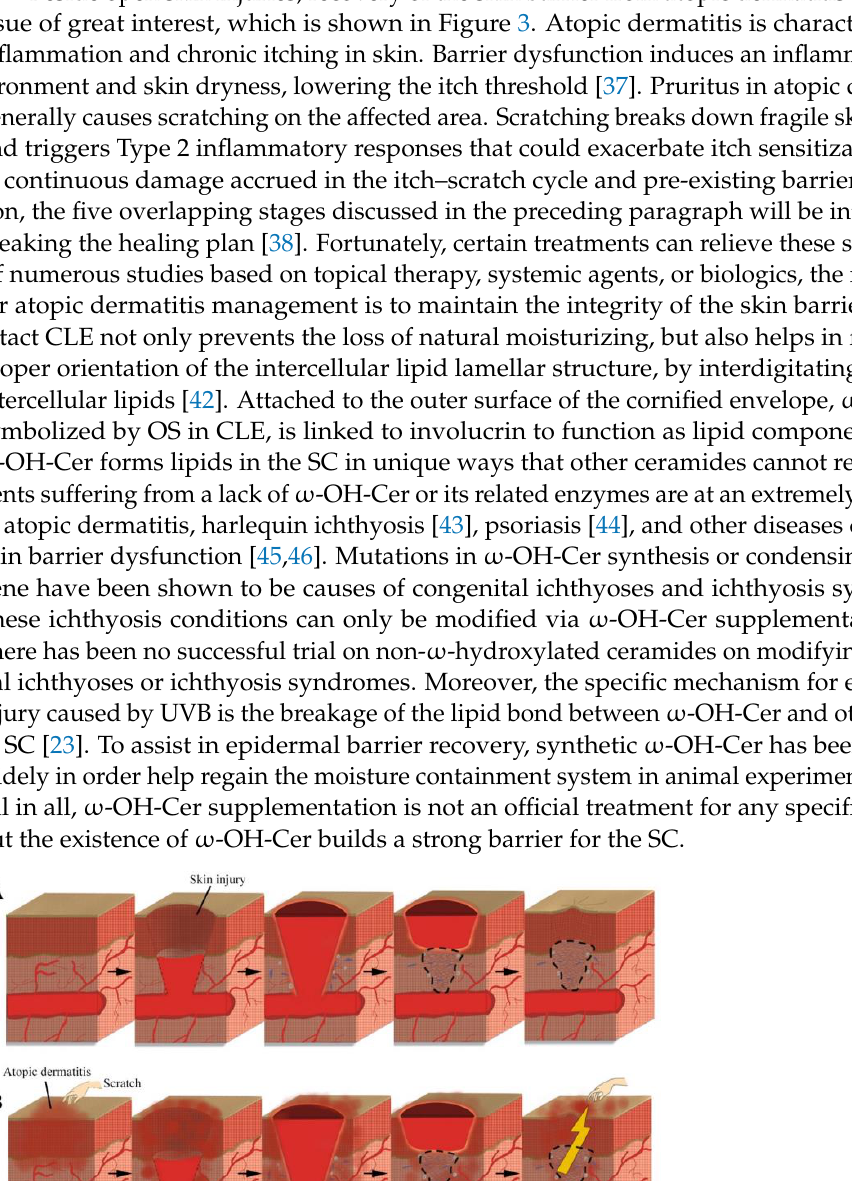
Figure 3. Schematic diagram of epidermal barrier recovery. ( A ) Epidermal barrier recovery due to physical skin damage. ( B ) Epidermal barrier recovery due to a lesion from atopic